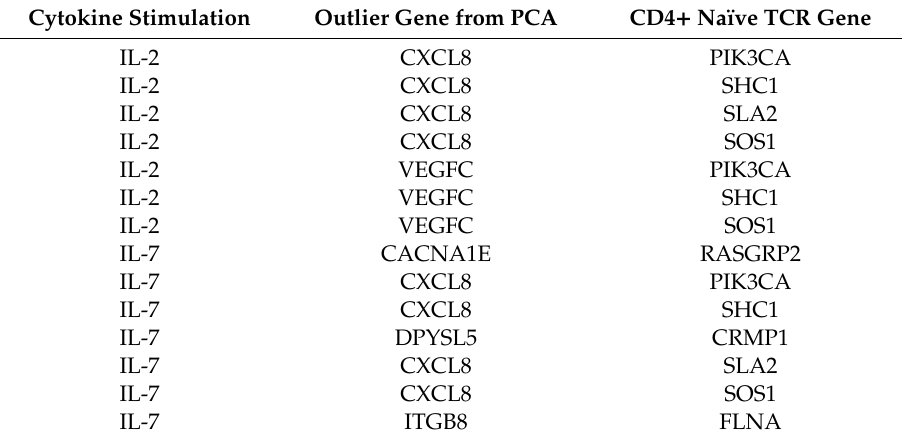
Table 5. The outlier genes shown in Figure 4 that are involved in TCR signaling. The data were generated through RNA sequencing of samples for the no cytokine, 000, 200, 020, and 002 conditions, and the listed genes were identified from that set through principal component